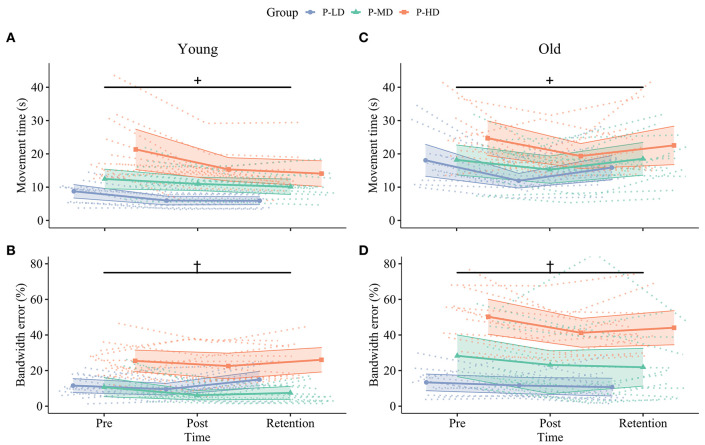
Change in speed (upper row, A,C) and accuracy (bottom row, B,D) over time for younger (left column, A,B) and older (right column, C,D) participants in the different practice groups. Dotted lines in the background show individual trajectories and shaded areas represent the 95% confidence intervals. Improvements in movement time from pre to post were greater in the P-LD and P-HD groups (+, significant Time*Practice group interaction, p = 0.01). Furthermore, younger adults only consolidated improvements in movement time (A), while older adults only consolidated improvements in bandwidth error (D). Practicing at a high difficulty level hindered motor skill retention of bandwidth error in older, but not younger adults (†, significant Time*Age*Practice group interaction, p = 0.03). Blue: Practice with Low Difficulty (P-LD), green: Practice with Medium Difficulty (P-MD), orange: Practice with High Difficulty (P-HD).